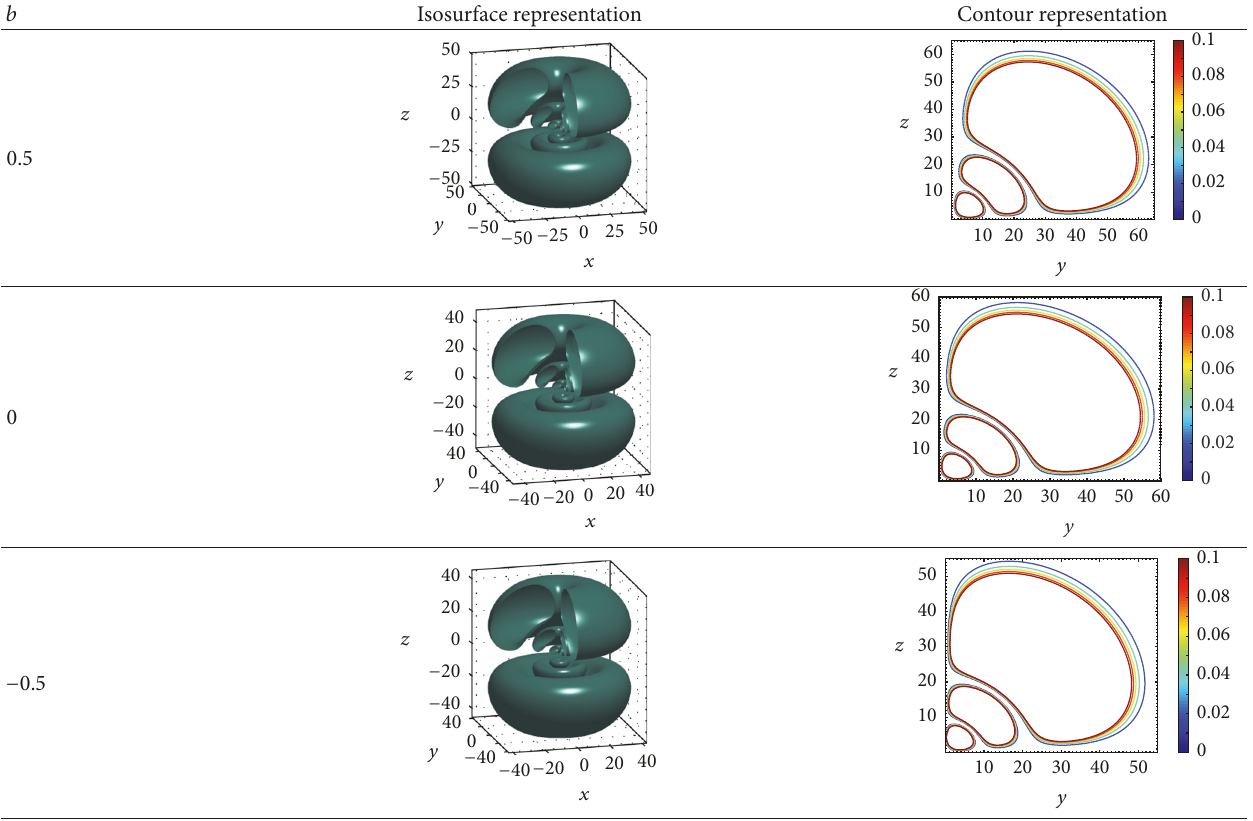
Table 6: Space probability distributions for positive and negative parameter 𝑏 for ( 5,2, 1 ).